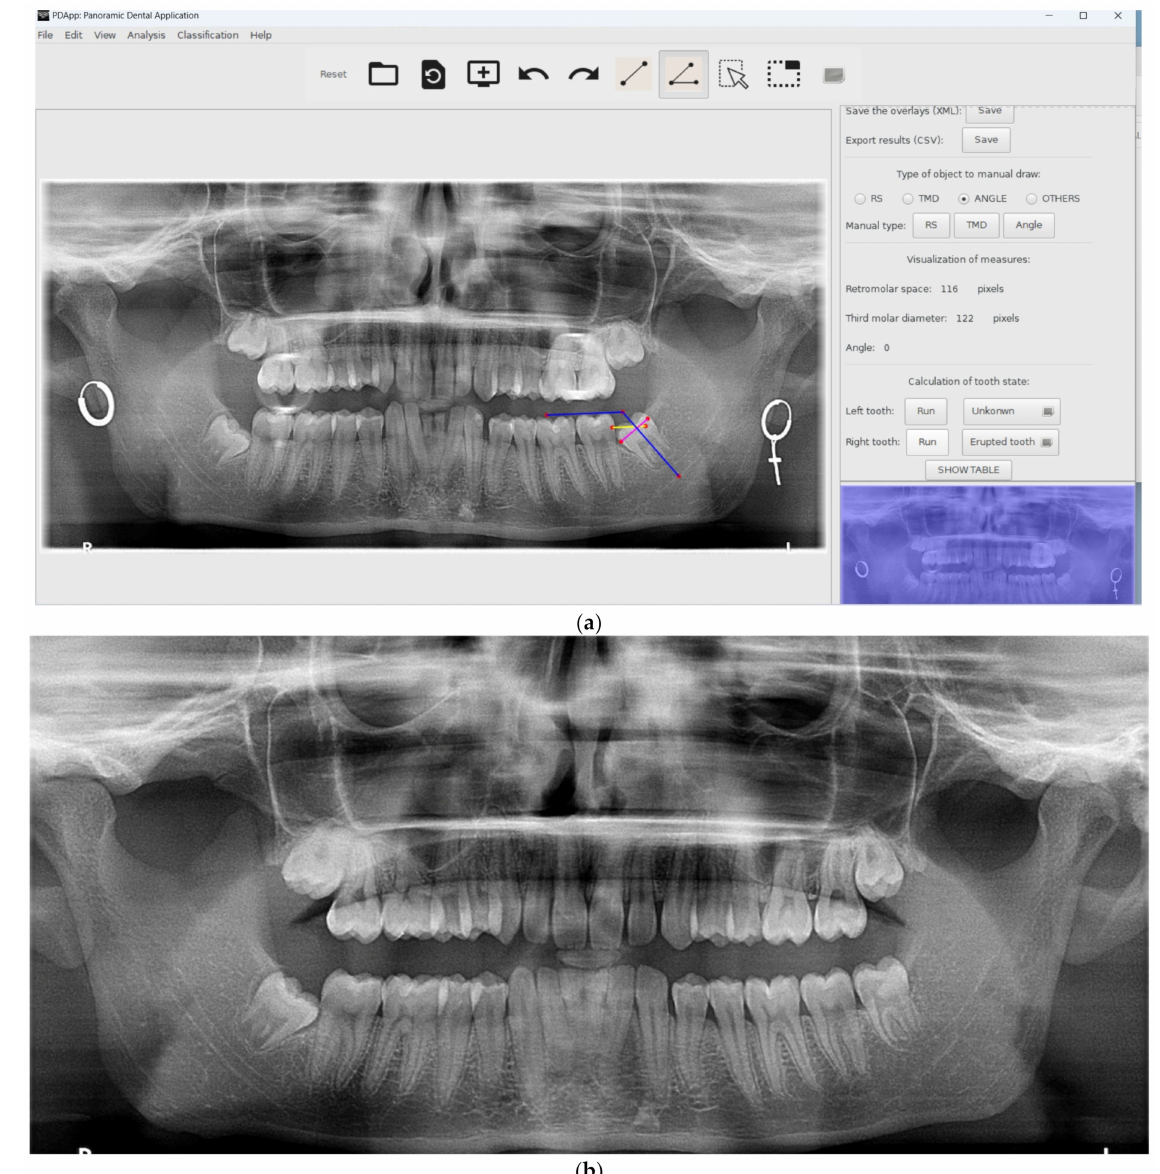
Figure 5. Visual example of correct prediction The pink line represents third molar diameter, the yellow line represents retromolar space, and blue lines represent the angle of eruption: image ( a ) shows partial retained third molar is classified as erupted tooth by the software; image ( b ) confirms the eruption of third molar (panoramic one year later). The screenshots have been taken using the windows version of